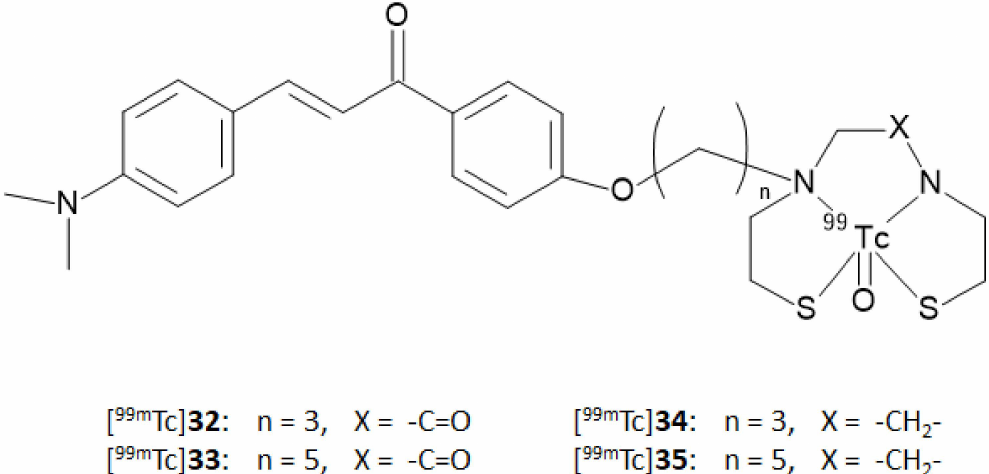
Figure 12. Structures of [ 99m Tc]-labeled BAT and MAMA-chalcone derivatives (compounds ([ 99m Tc] 32 – 35